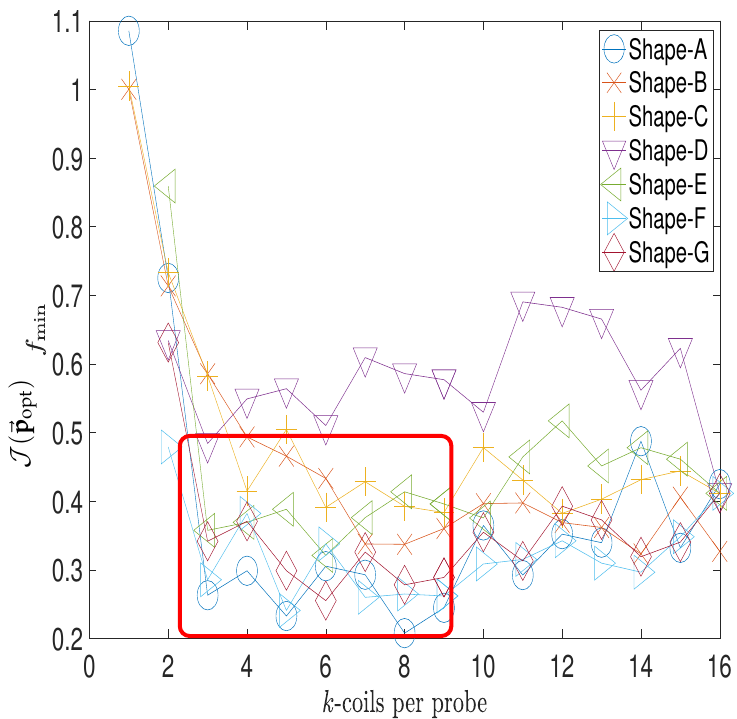
Figure 4. Plots of the minimal values of the merit function J ( (cid:126) p opt ) with respect to the number of coils (considered in one probe) for several different shapes of the deposition. Here, opt stands for optimal. The Surrogate optimization algorithm results in (cid:126) p opt as an optimal solution (among which we have the number N of coils in the probe), with the data of points ( J ( ,˛ p opt )) . The red box represents the selection of the cases that performed